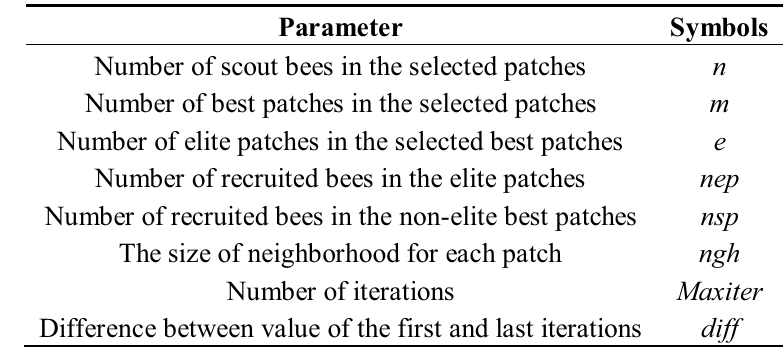
Table 1. Basic parameters of the Bees Algorithm.